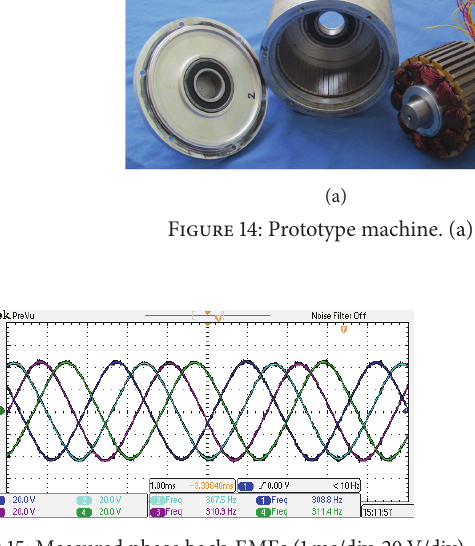
Figure 15: Measured phase back-EMFs (1ms/div, 20V/div). 00.511.522.533.5